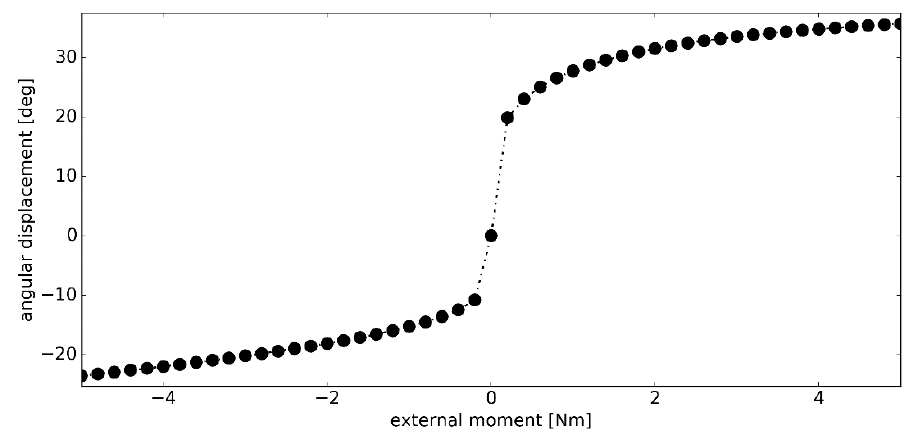
Figure 7. The angular displacement ∆ θ versus the external moment M ext in simulation #2.